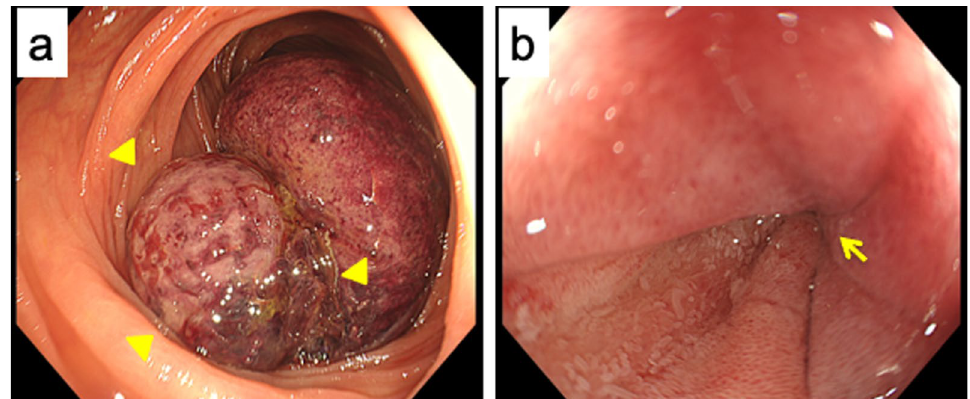
Fig. 2 a Preoperative colonoscopy shows the existence of a tumor at the lead point of the intussusception (arrowhead). b There was evidence of bowel obstruction (arrow) and bowel wall